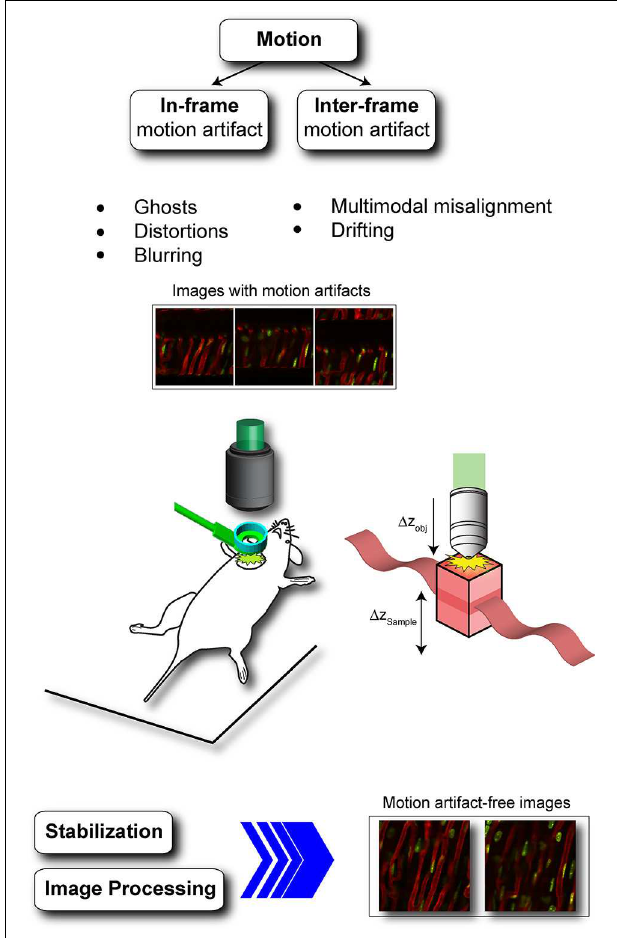
FIGURE 1 | Physiological movements induce motion artifacts in acquired images. In-frame and inter-frame are the two most common types of motion artifacts. In-frame motion artifacts refer to image degradation present within a single image and include ghosts, distortions and blurring while inter-frame motion artifacts refers to motion between consecutive frames due for example to multimodal misalignment and/or animal or imaging probe drifting. During in vivo heart imaging both classes of artifacts are present, making impossible to visualize the heart without the adoption of proper motion stabilization methods. Adapted from Lee et al.